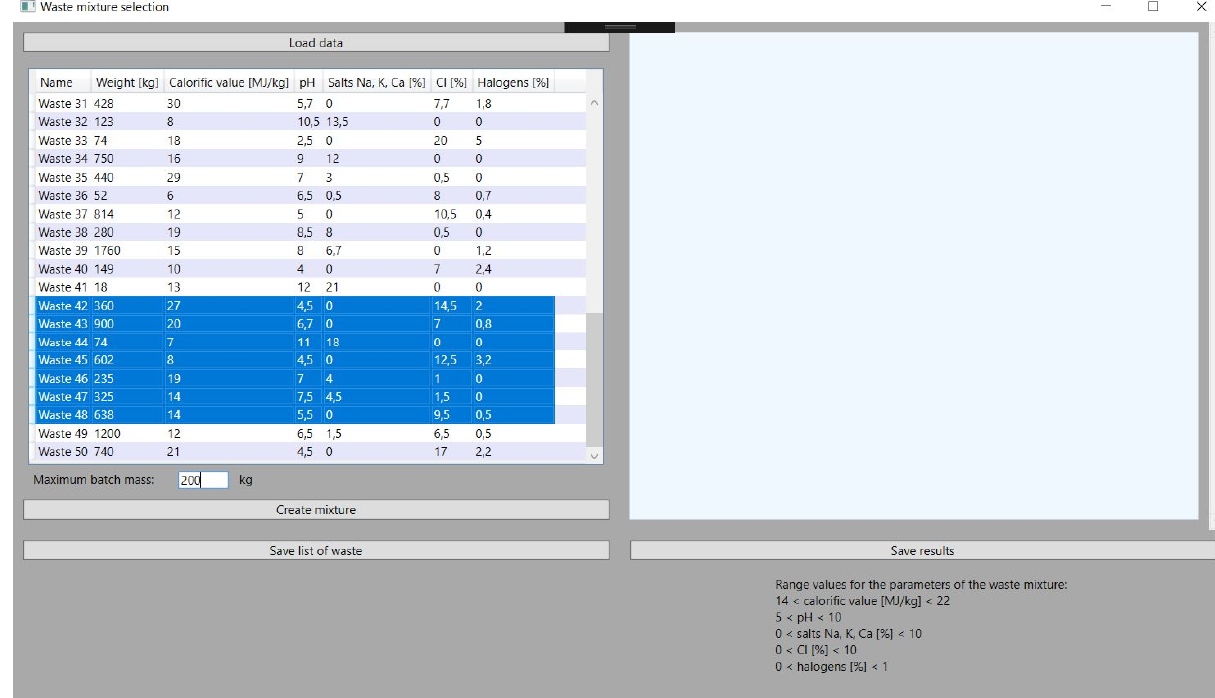
Figure 5. Selection types of waste from downloaded database of incineration plant.